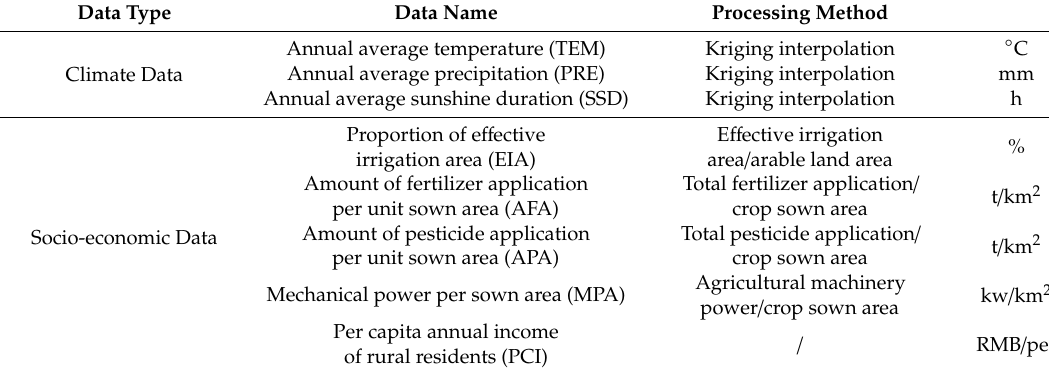
Table 1. Index selection and specific treatment